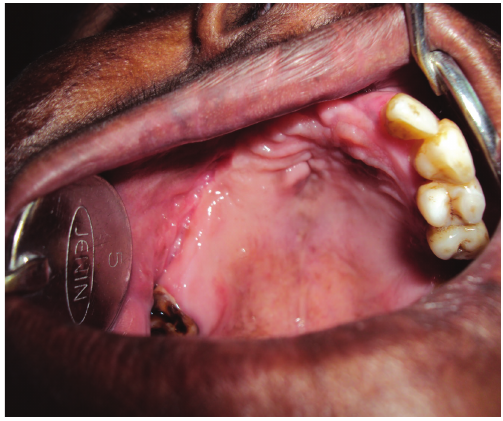
Figure 9: Postoperative photograph after 2 months of